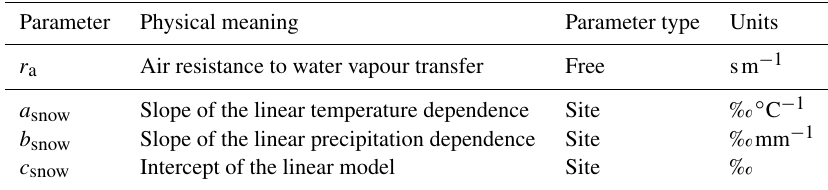
Table 1. New parameters introduced to MAIDENiso in the new